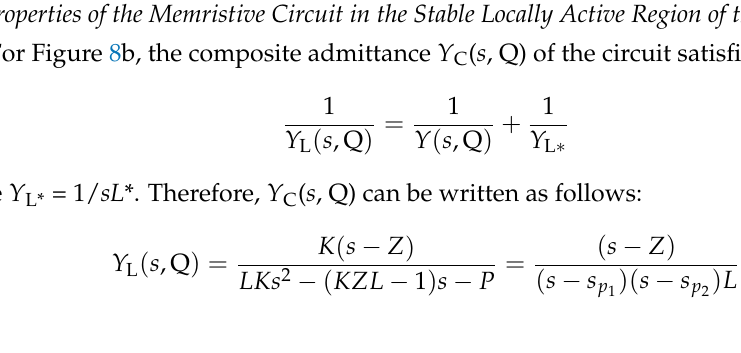
Figure 12. Variation in the real and imaginary parts of the poles of the admittance function in the oscillation circuit with the external capacitance (if V = 0.6000 V).